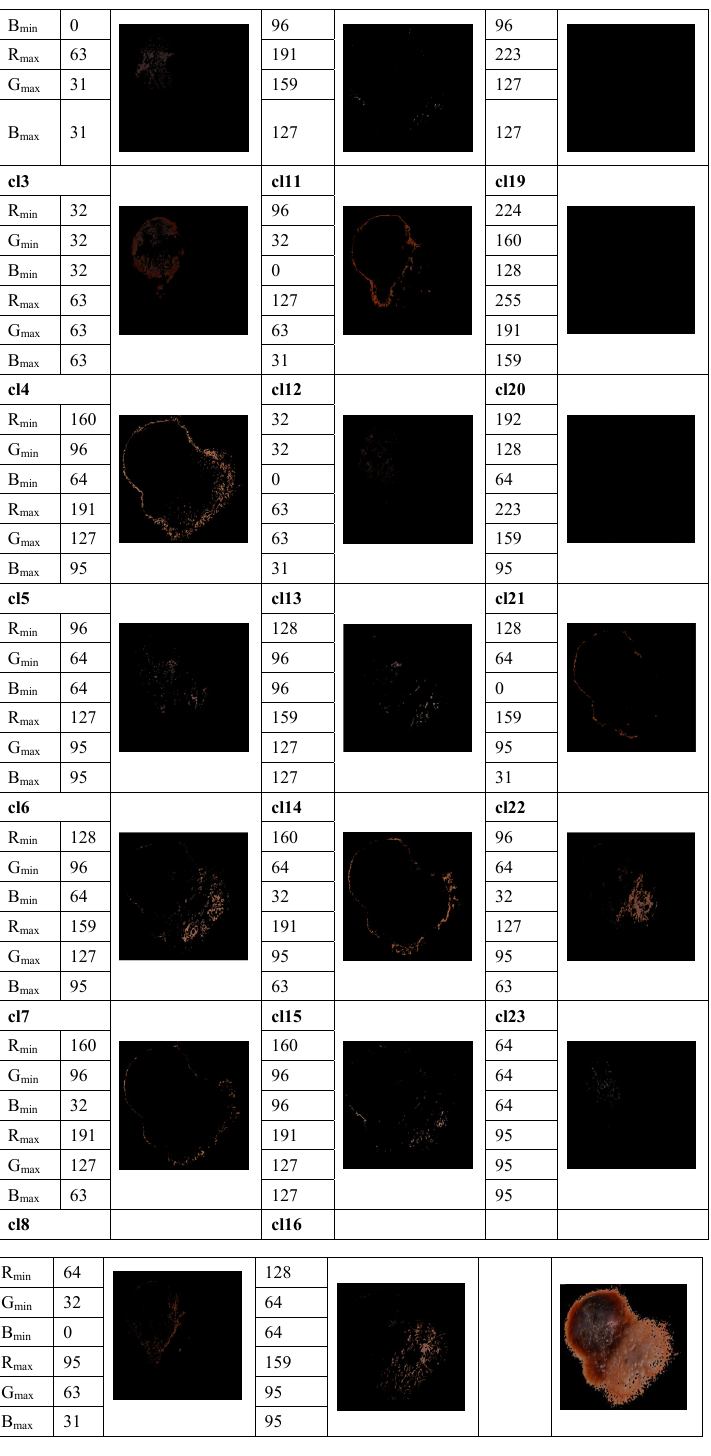
Figure 3. Example of measuring the color content and clustering method to select the relevant color distribution in melanocytic lesion images. 23 color clusters, denoted as cl1, …, cl23, are presented. Data for the minimum and maximum intensity in each R, G, and B channel are indicated for each color cluster. Lower right: the segmented image.